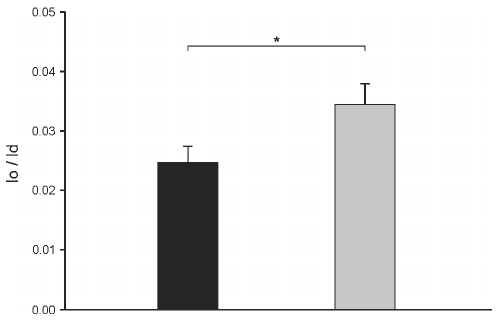
Figure 5. Distribution of the lipid analog N -Rh-DOPE (0.5 mol %) between the lo and the ld domain in GUVs consisting of DOPC/SSM/cholesterol (1:1:1) (black column) or DOPC/SSM/ α -spinasterol (1:1:1) (gray column). From images as shown in Figure 4, fluorescence intensities of N -Rh-DOPE localized in lo and ld domains were determined and a lo/ld ratio was calculated (see Materials and Methods). The data represent the mean ± SE of 60 vesicles, p -value < 3% (corresponding to *).